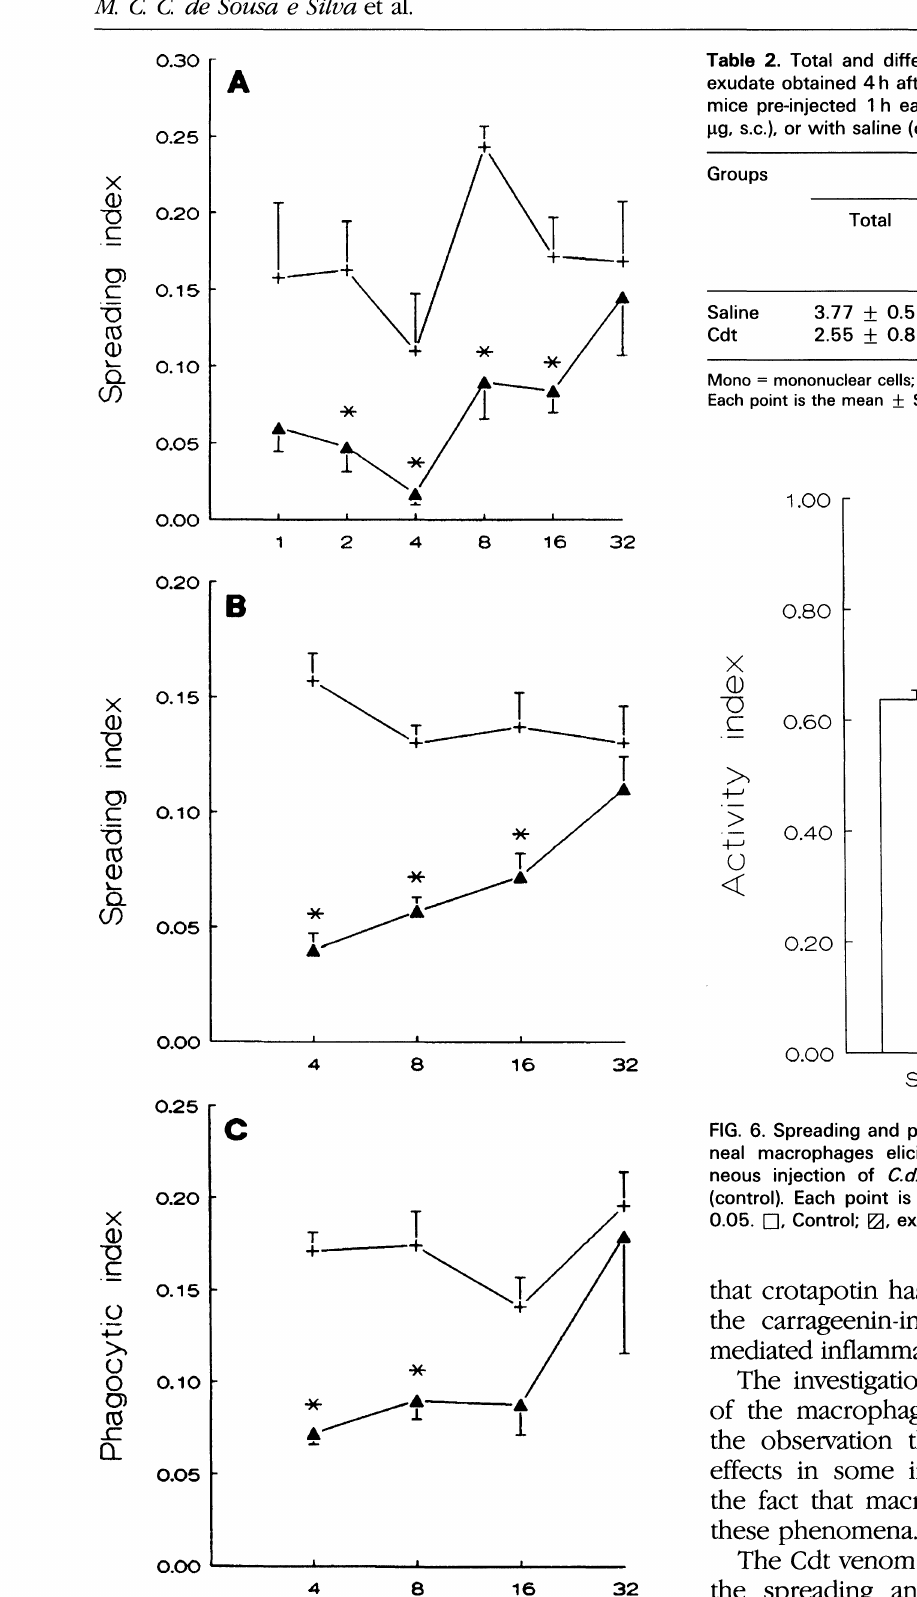
FIG. 5. Effect of the injection of C.d.terrificus venom i.p. (A) or s.c. (B,C) on the spreading (A,B) an, d phagocytic (C) activities of resident peritoneal macrophages of mice. Each point is the mean S.E.M. of six to eight mice. *p < 0.05. +, Control; A, experi- ment.